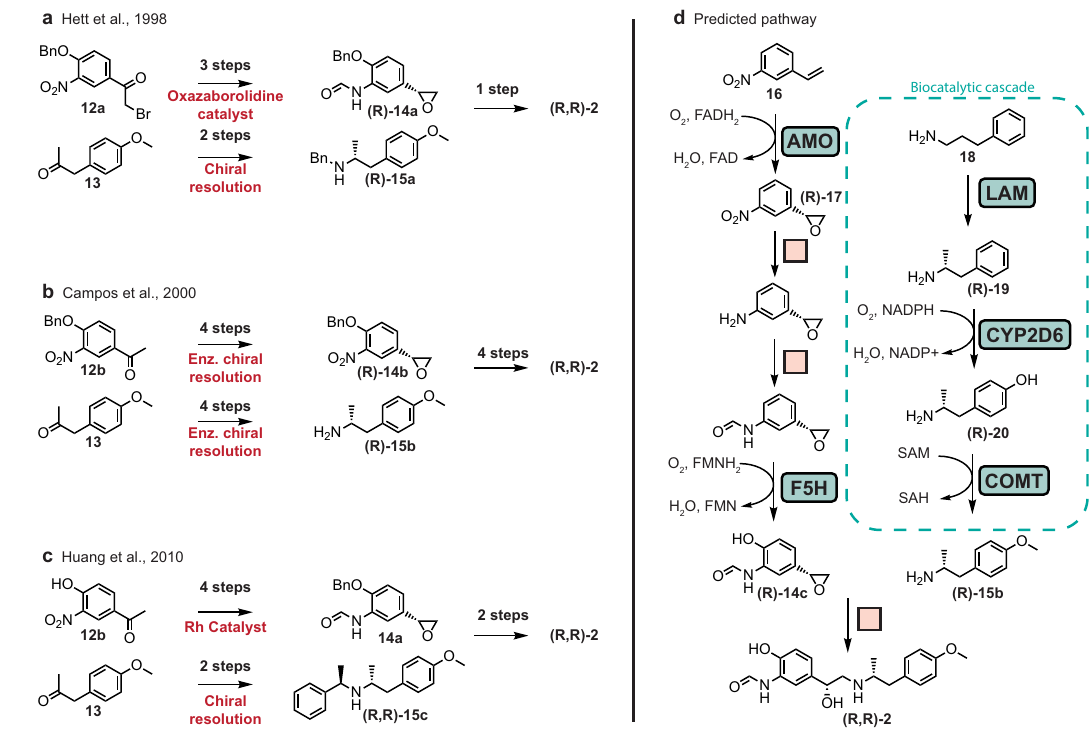
Fig. 8 | Previously published and newly proposed syntheses of arformoterol. a – c Overview of published syntheses of arformoterol. d Proposed hybrid synth- esis plan. Enzyme names were assigned to steps based on the most structurally similar precedent reaction for reference. Arformoterol does not appear in the